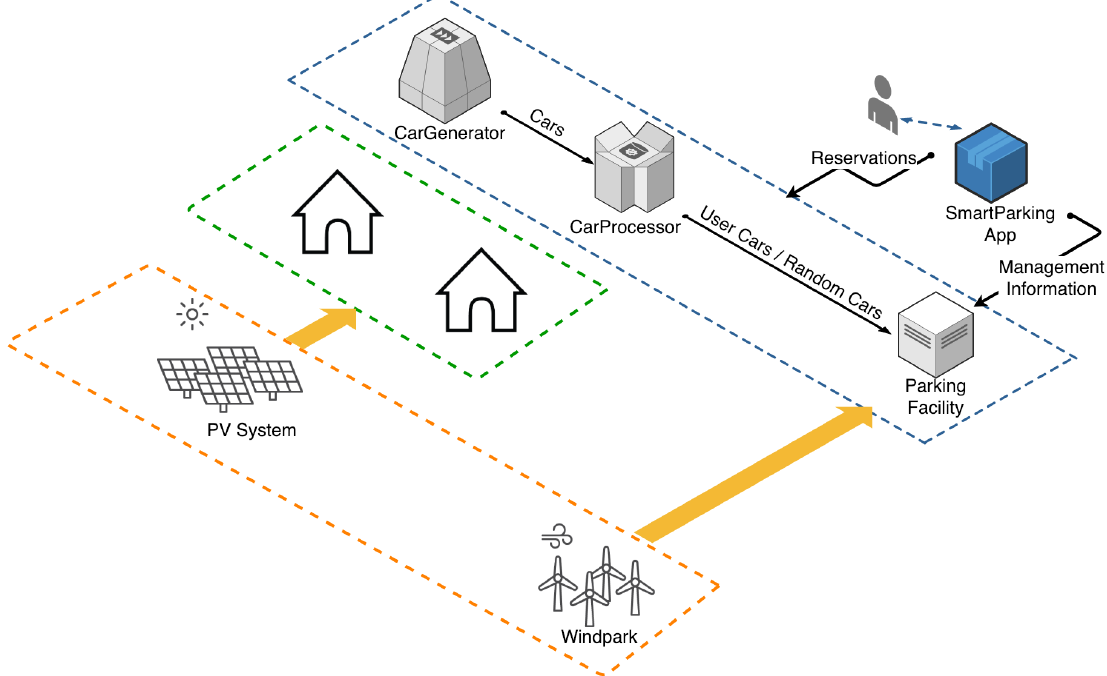
Figure 5. Smart energy use case: Level